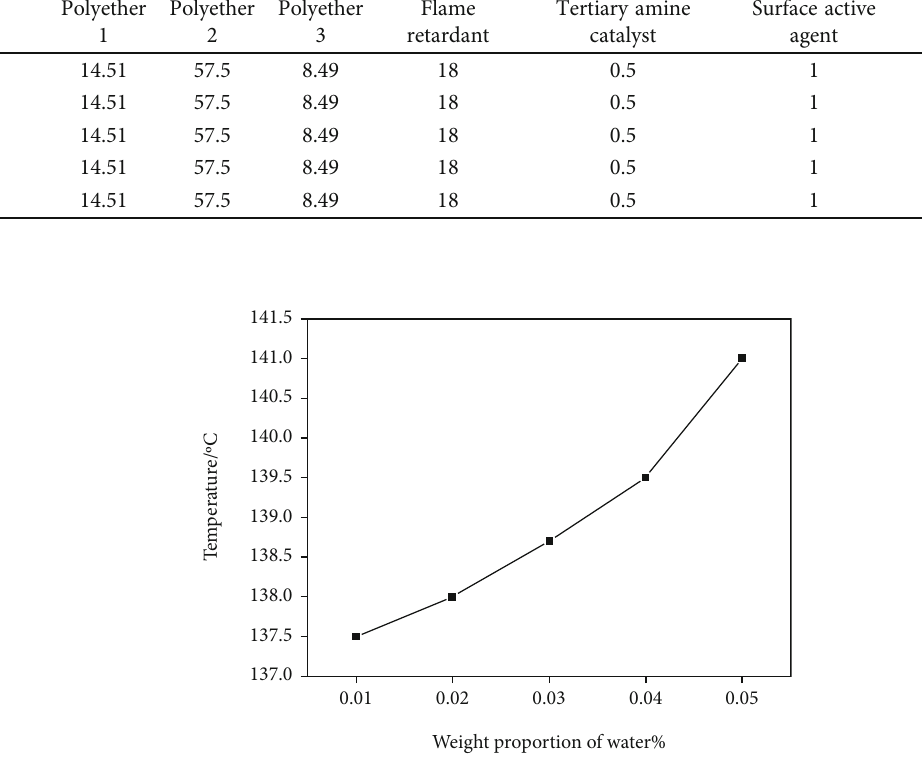
Figure 5: In fl uence of the weight proportion of water on the curing temperature